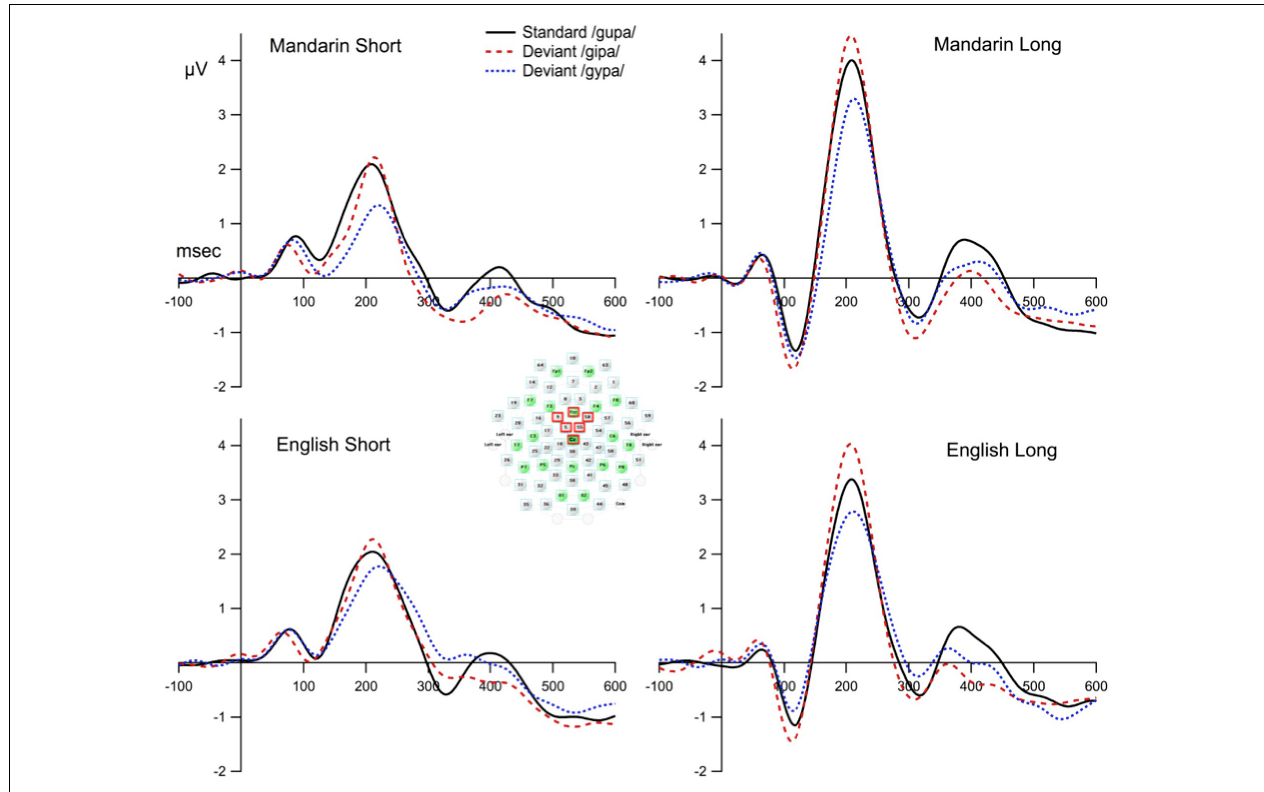
FIGURE 2 | The waveforms at the composite FzCz site for the standard and deviant stimulus condition. The composite FzCz site was generated using the average of six sites near FzCz (these sites are marked with red squares).